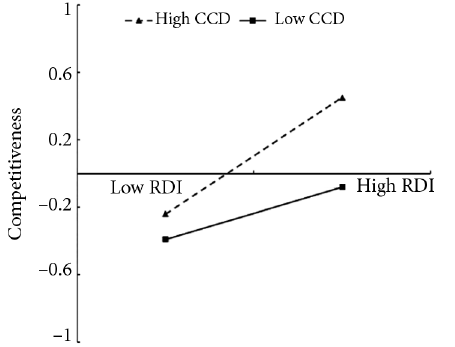
Figure 3. Moderating effect of the coupling degree on the relationship between RDI and CC CCD played a positive role in moderating the relationship between IO and CC (Figure 4).